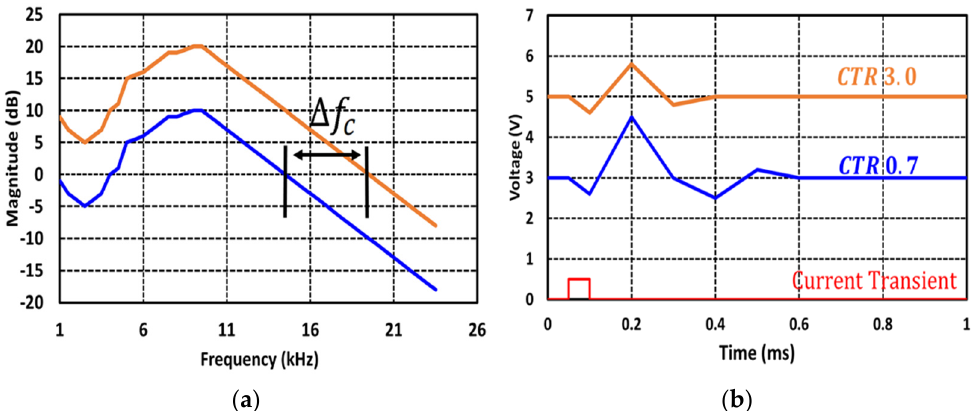
Figure 26. CTR CM for opto–isolator. ( a ) Shift in crossover frequency due to a decreased CTR. ( b ) Voltage response to current impulse with two different CTRs [60].